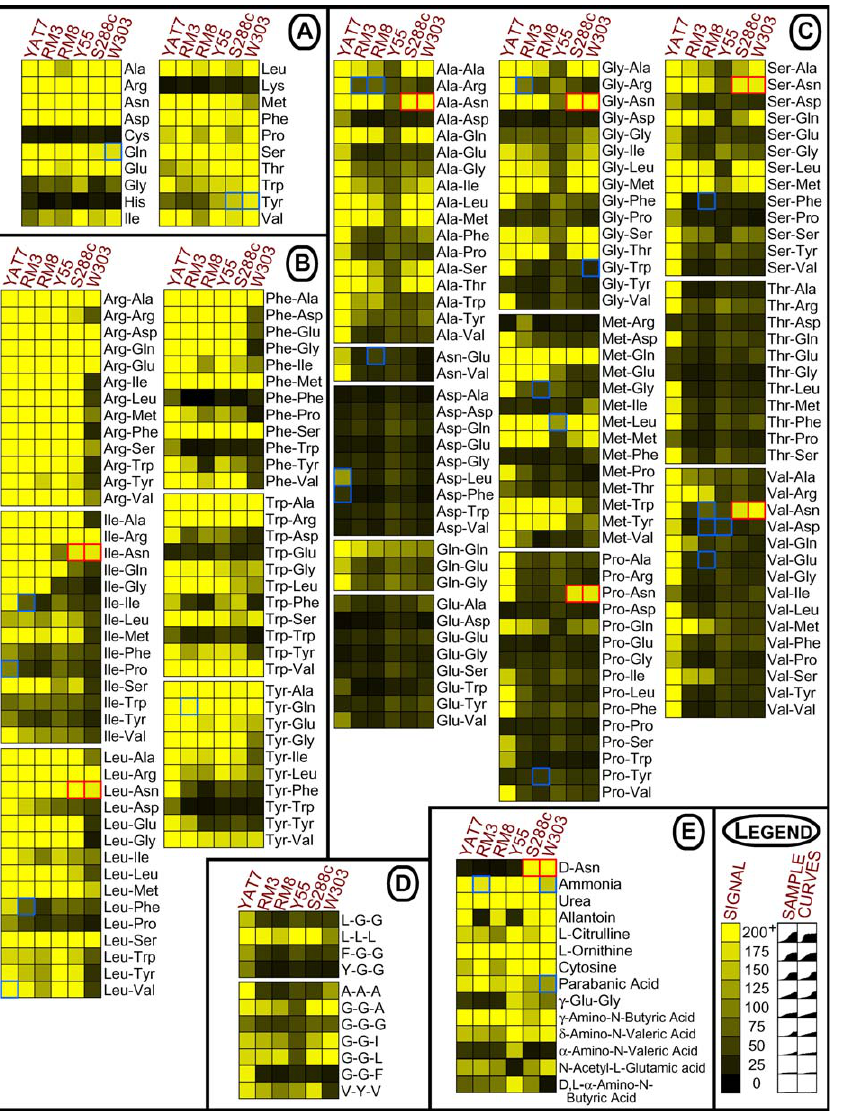
Figure 2. Variation in Nitrogen Source Utilization among Six Strains of S. cerevisiae Each square represents the growth of one strain in the PM assay supplied with the indicated nitrogen source. The value reflecting the extent of growth was generated from the 48-h signal curve of the PM assay and represented by the intensity of coloration, as shown in the legend. All signal values exceeding 200 reflected very robust growth, and are therefore represented with the same color. Blue-bordered squares denote nitrogen sources that produced varying results in that strain, exhibiting substantial variation in signal among replicates ( r 2 /mean . 10 and at least one replicate with signal . 50 or , 200). Red-bordered squares denote putative substrates of the Asp3p asparaginase. (A) Amino acids, (B) N-end rule dipeptides, (C) non–N-end rule dipeptides, (D) tripeptides; amino acids are represented as single letters, and (E) miscellaneous nitrogen sources. DOI: